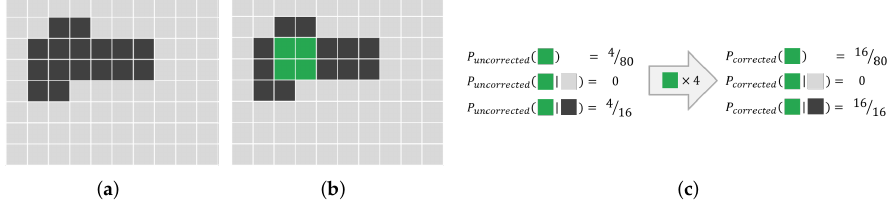
Figure 3. Schematic explanation of the idea behind weight-based PU-learning. ( a ) Original image: The bright and dark pixels of the image represent its two classes. ( b ) Original image with segmentation overlayed: The green pixels show that the sparsely annotated areas are the sparse annotations. ( c ) Probability of the green class: The probability of annotations given for different preconditions. If the weight for annotated pixels artificially increased, the annotation probability matches the original class